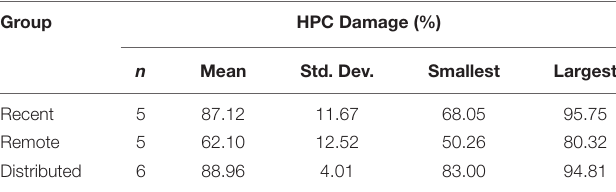
TABLE 2 | Descriptive Statistics of the HPC lesion size in each group of Experiment 1.